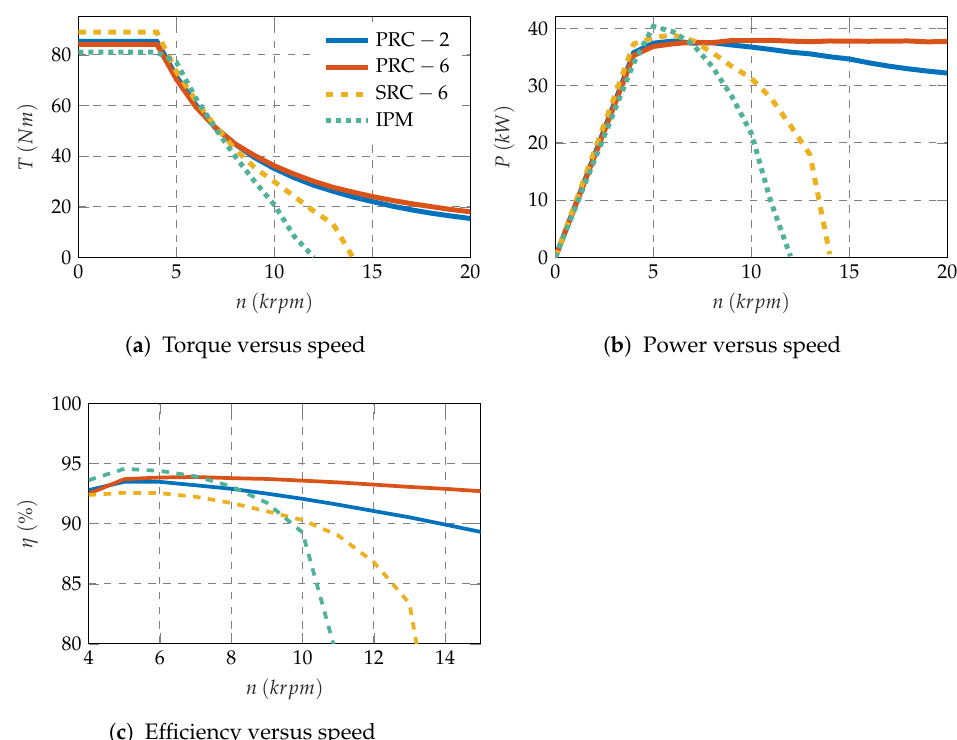
Figure 16. Torque, power and efficiency comparison: PRC-2, PRC-6, SRC-6 HEPM and V-shape IPM